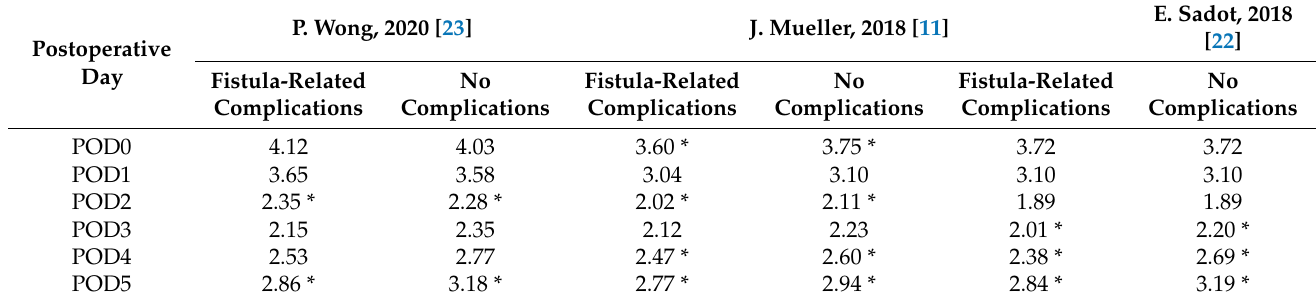
Table 2. Comparison of patients’ serum phosphate levels (mean) according to whether they developed POPF or not